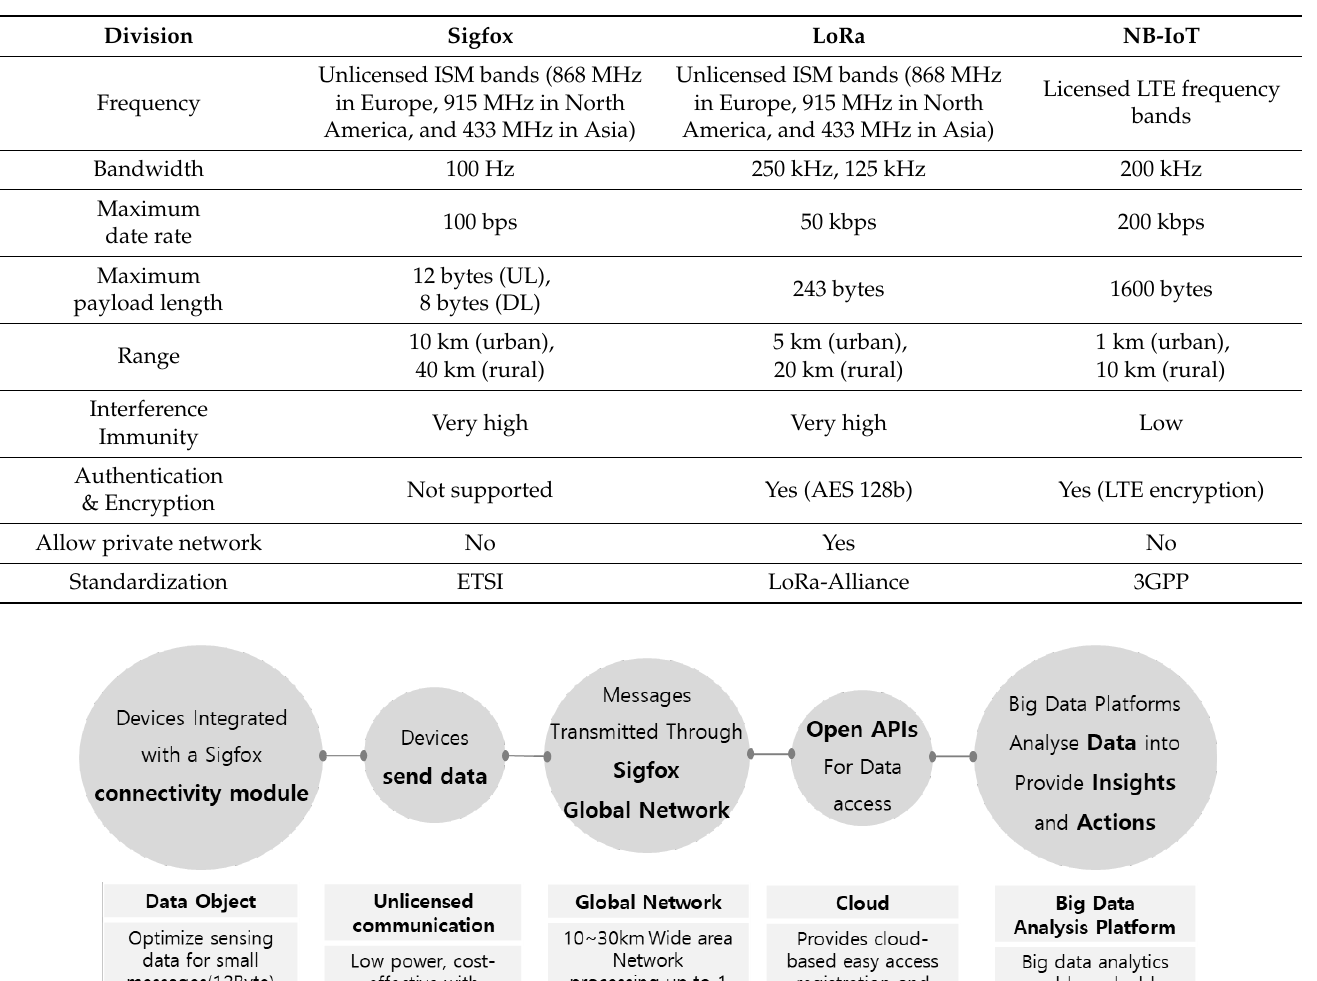
Table 2. Overview of LPWAN technologies: Sigfox, LoRa, NB-IoT [2].